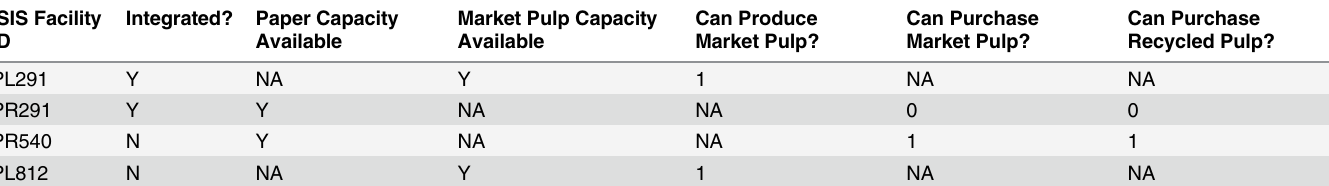
Table 3. Mill classification